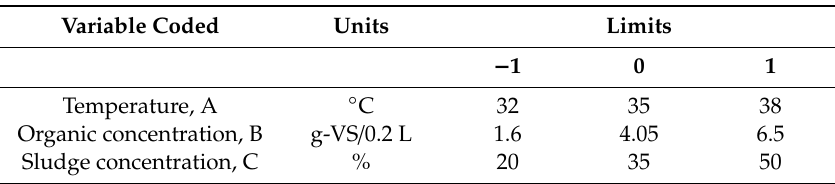
Table 1. Independent variables with their